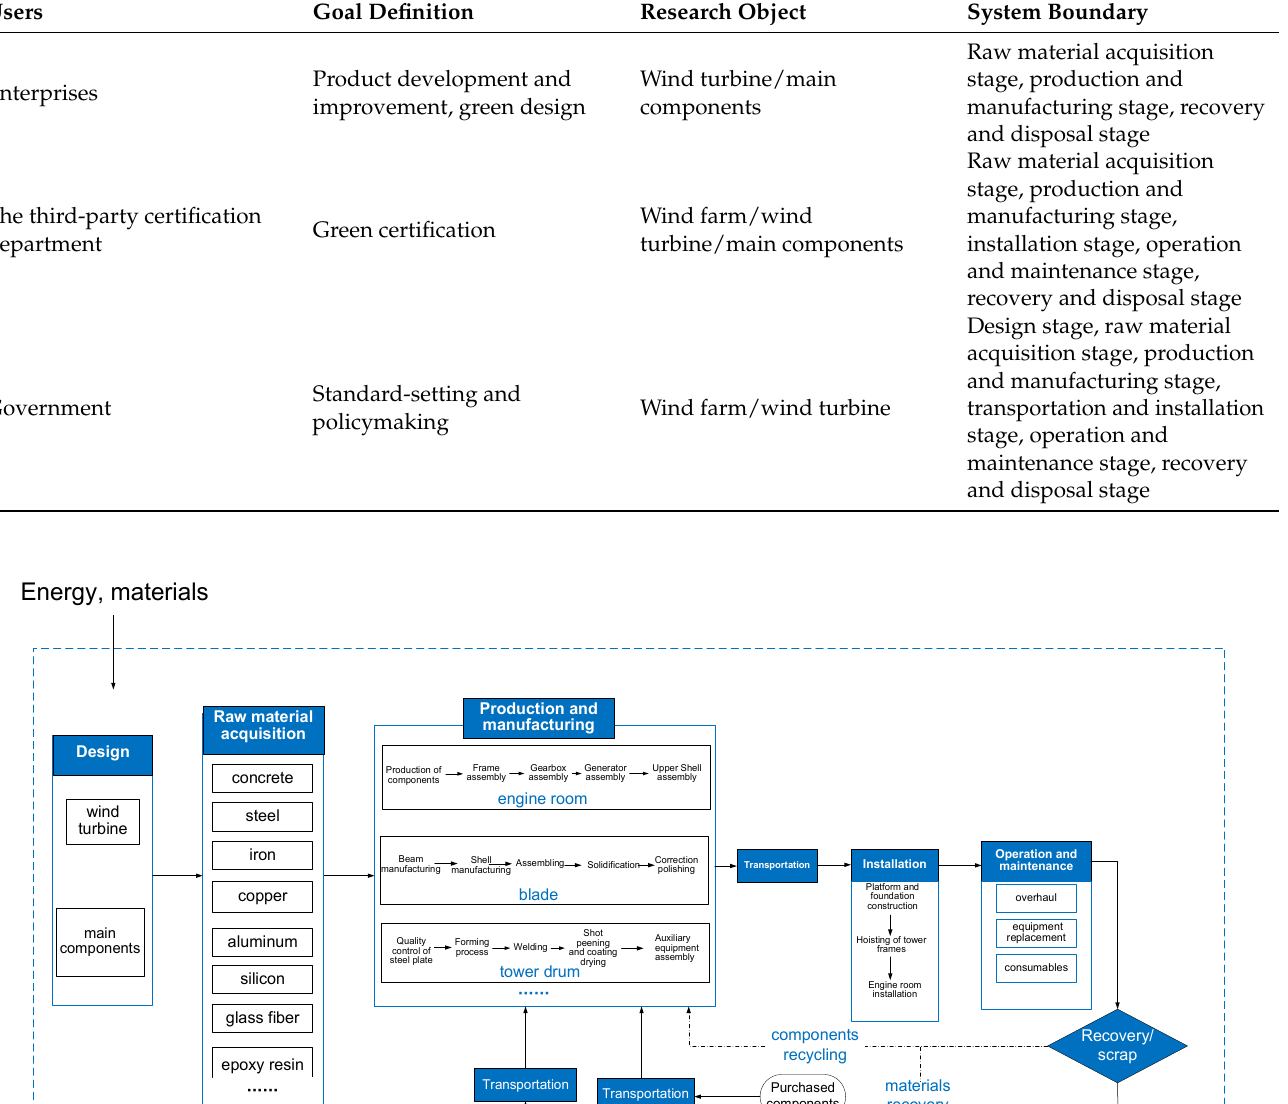
Table 1. The research objectives and scope of LCA for the wind turbine.